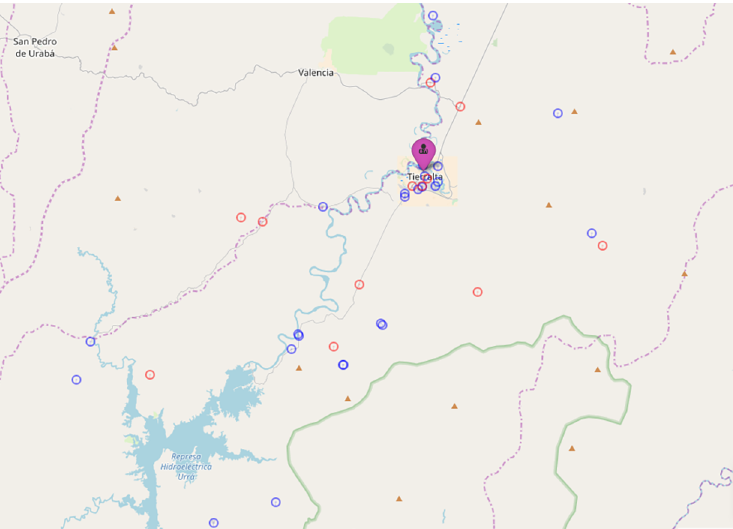
Fig 1. Residence of women included in the study. Red circles: Plasmodium falciparum malaria cases; Blue circles: Plasmodium vivax cases. Purple marker: San Jose´ hospital.